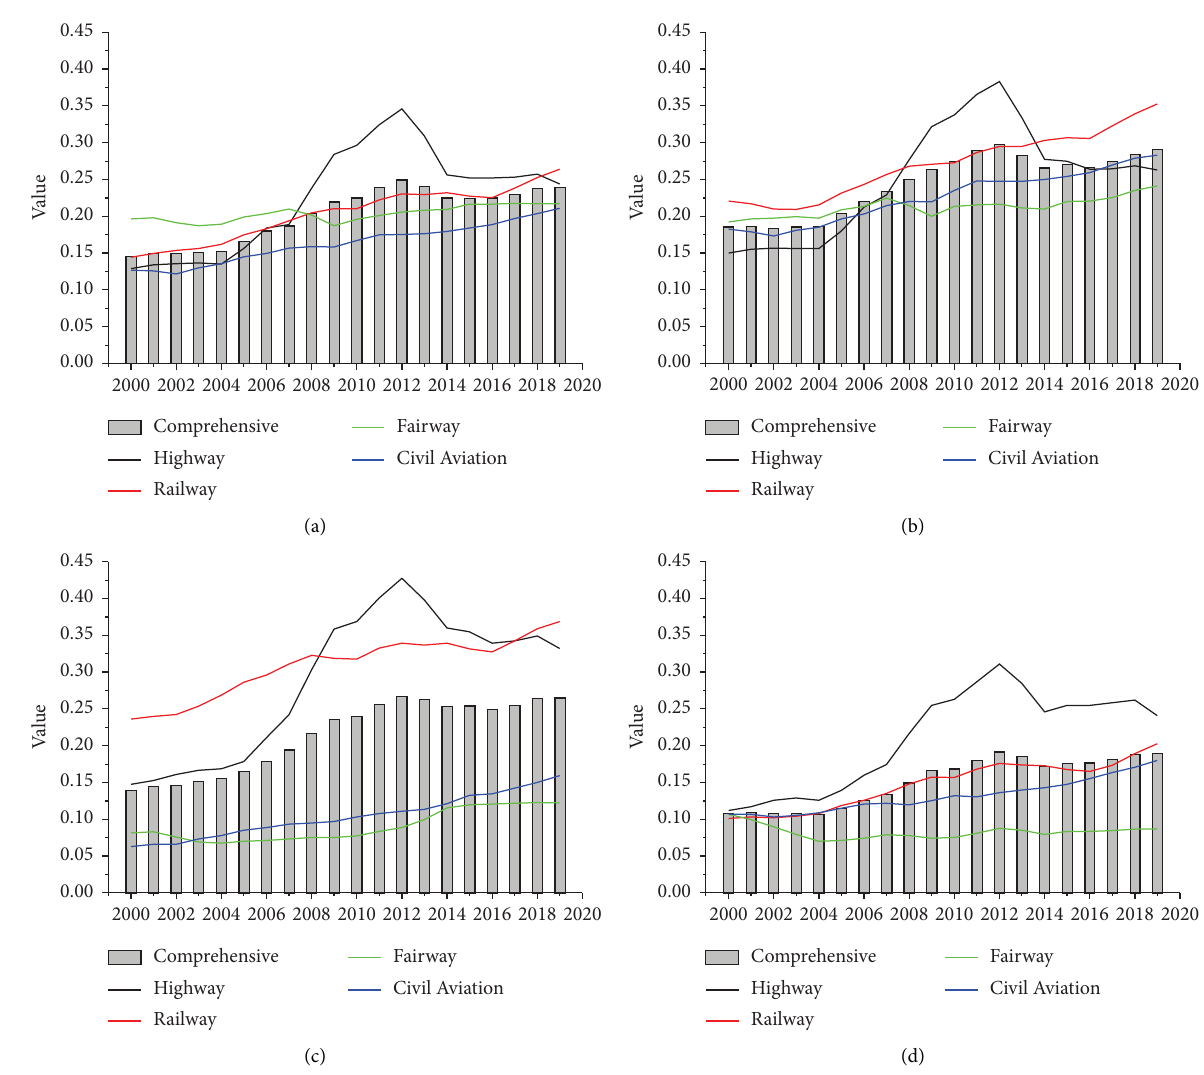
Figure 3: Evaluative value changes in the four modes of transport in the nation as a whole and in the eastern, central, and western regions. (a) Mainland China. (b) Eastern China. (c) Central China. (d) Western